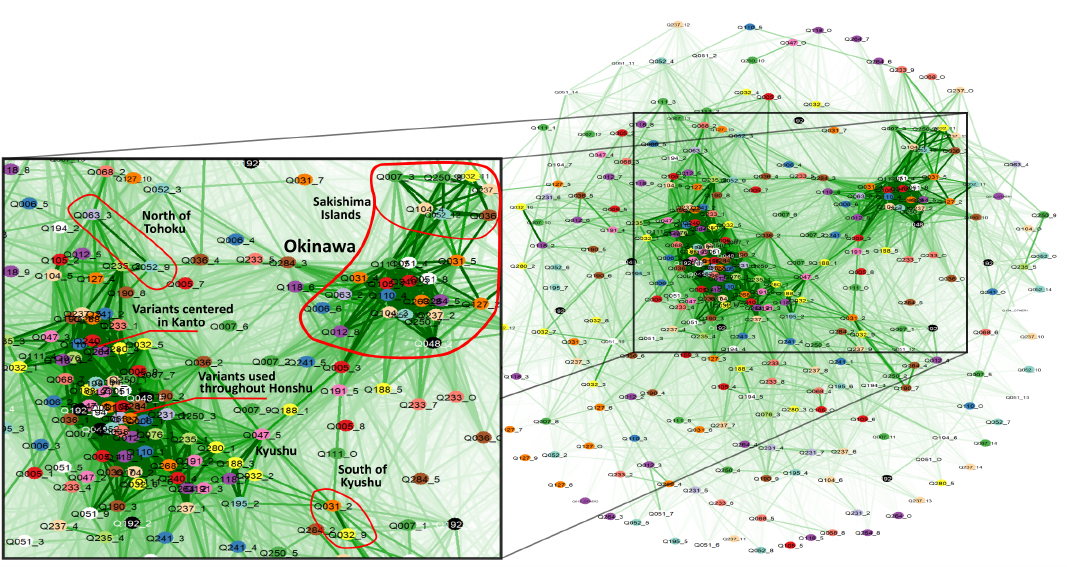
Figure 6. Graph presenting the occurrence overlap in variant categories, based on the Jaccard-index. Survey questions represented by the same colour are not related. For example Q188_5 means the 5th variant category in survey question nr. 188 in the original